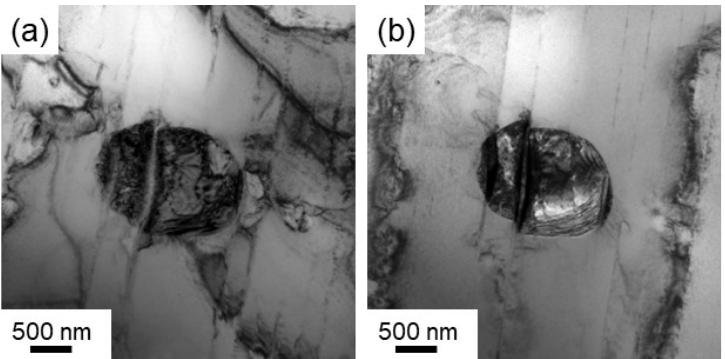
Figure 7. TEM images of ( a ) and ( b ): the κ carbide of A500 sample was sheared by the slip